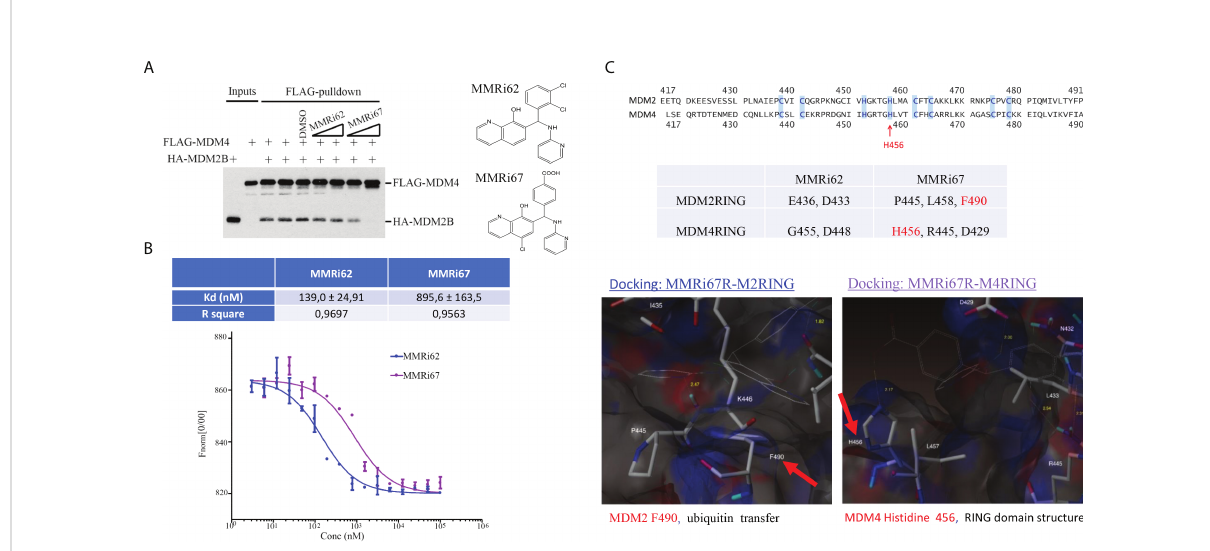
FIGURE 2 Characterization of drug – target interactions in vitro . (A) Left, in vitro pulldown assay with recombinant FLAG-MDM4 and HA-MDM2B in the presence of solvent dimethyl sulfoxide (DMSO) or 5 and 10 m M of MMRi62 or MMRi67. After anti-FLAG pulldown, the FLAG-MDM4-bound HA- MDM2B was detected by Western blotting (WB) with anti-HA antibody. Right, chemical structures of MMRi62 and MMRi67. (B) Measurement of the binding af fi nity of MMRi62 and MMRi67 to preformed RING – RING heterodimers of MDM2 and MDM4 in microscale thermophoresis (MST) analyses. MST analyses were performed in the presence of MMRi62 or MMRi67 at concentrations ranging from 3 nM to 100 m M obtained through serial dilutions. The fl uorescence intensities (y-axis, Fnorm%) were normalized to the overall highest detected signal. The equilibrium dissociation constant between the MMRi62/MMRi67 and RING heterodimers (Kd) is presented. Top, the calculated Kd for MMRi62 and MMRi67; bottom, the fi tting curve of the measurements using MO.Af fi nity Analysis software. (C) Molecular modeling of interaction interfaces for the RING domains of MDM2 and MDM4 with MMRi62 and MMRi67. Top, amino acid alignment of RING domains of MDM2 and MDM4. Middle, the interaction residues of RING domains with MMRi62 and MMRi67 identi fi ed by docking analysis. The F490 region in the MDM2 RING is critical